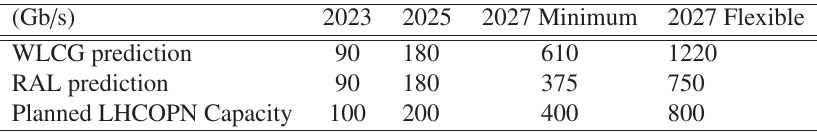
Table 1. Table showing the predicted network bandwidth required between CERN and the RAL Tier-1 in the years running up to the